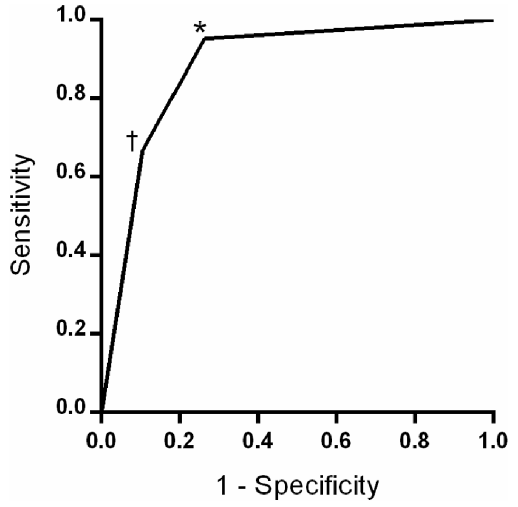
Figure 3. ROC curve showing the diagnostic validity of the point-of-care device for the identification of DSP as defined by electrophysiological criteria from standard NCS. An optimal threshold of one abnormality in SNAP or SNCV (*) had a sensitivity and specificity of 95% and 71%, respectively. An optimal threshold of abnormalities in both parameters ( { ) had a sensitivity and specificity of 67% and 89%, respectively.